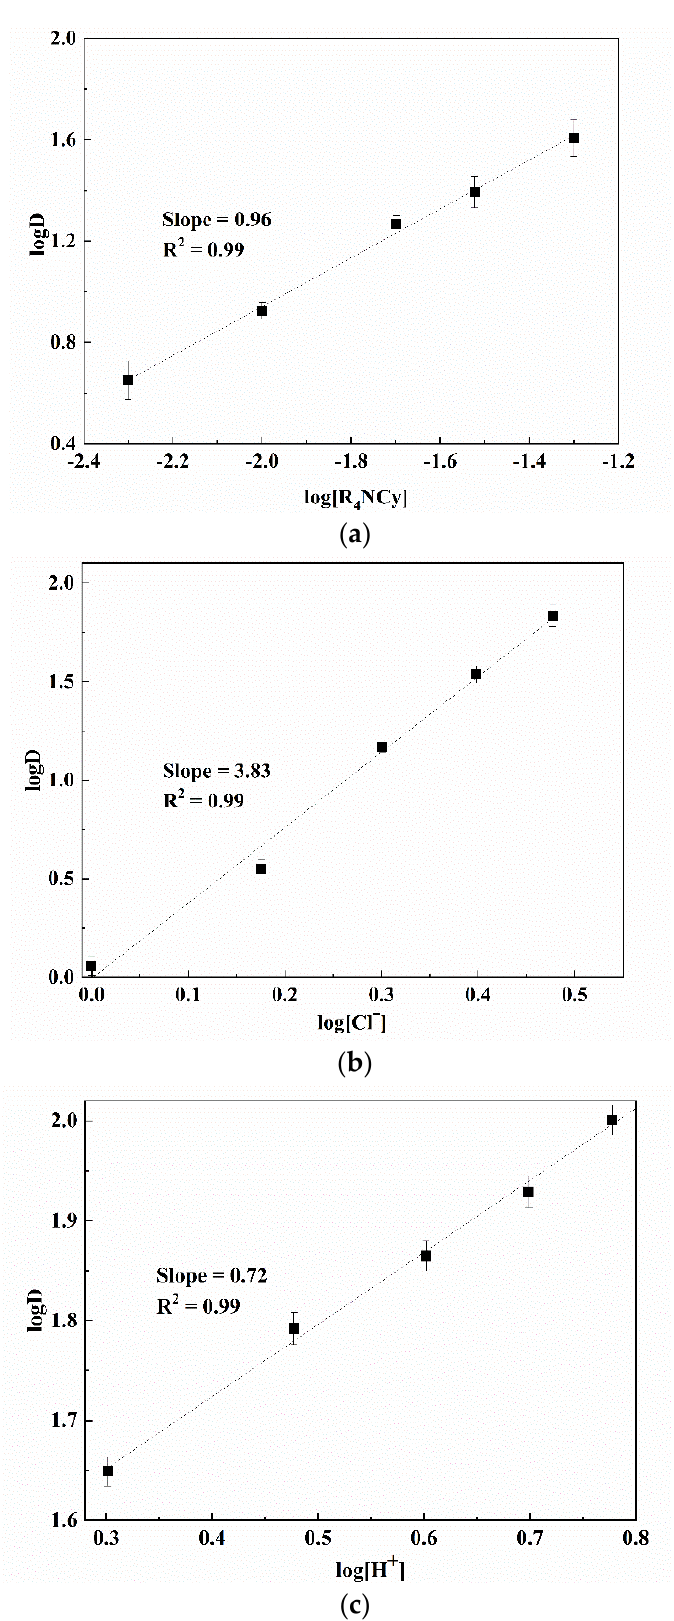
Figure 3. Effects of [R 4 NCy], [Cl − ] and [H + ] concentrations on the extraction of Ga(III) at high acidity. ( a ) logD vs. log[R 4 NCy]; ( b ) logD vs. log[Cl − ]; ( c ) logD vs. log[H + ]. The linear relationships between logD versus log[R 4 NCy], log[Cl − ] and equilibrium pH at a low-acid concentration range were obtained with slopes of 4.05, 0.78, and 1.76, respectively (Figure 4). The slope values reveal that the stoichiometries of [R 4 NCy] org , [Cl − ] aq and [H + ] aq were approximately 4, 1 and 2, respectively. Accordingly, the extraction mechanism of Ga(III) from relatively low-acidity solu- tions using [R 4 NCY] system can be represented by the following Equation (4):